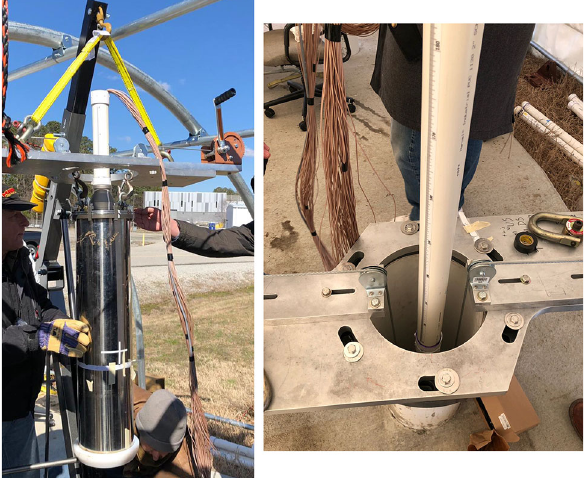
Fig. 2 Some pictures of BDX-Mini detector positioning phases. Left Panel shows the BDX-mini detector inside the stainless-steel watertight cylindrical vessel. Right Panel shows the detector lowering phase in the pipe: a PVC segment with the attached tape is clearly